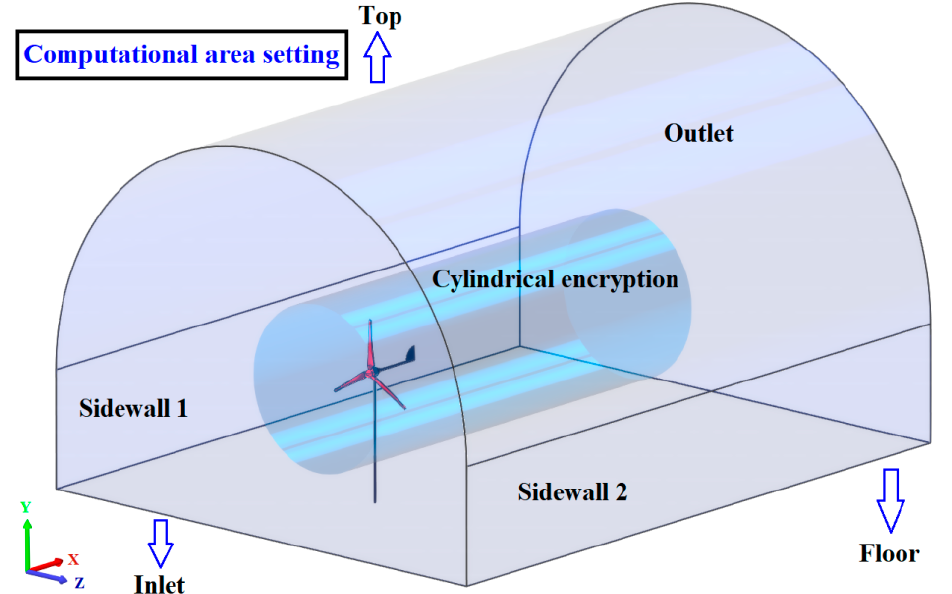
Figure 4. The computational area setting for an integral wind turbine.